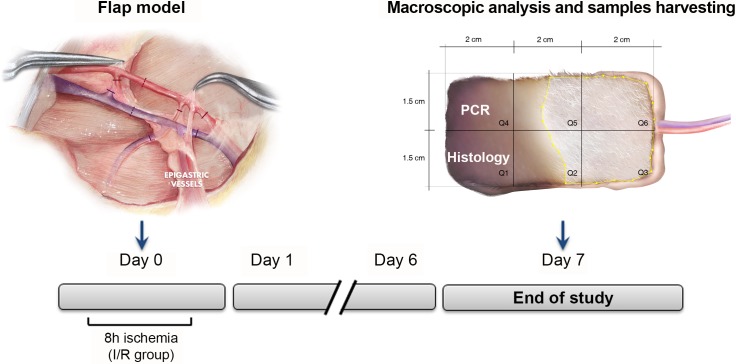
Experimental design.